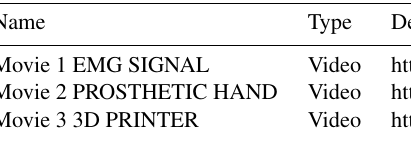
Table A1. Index to video